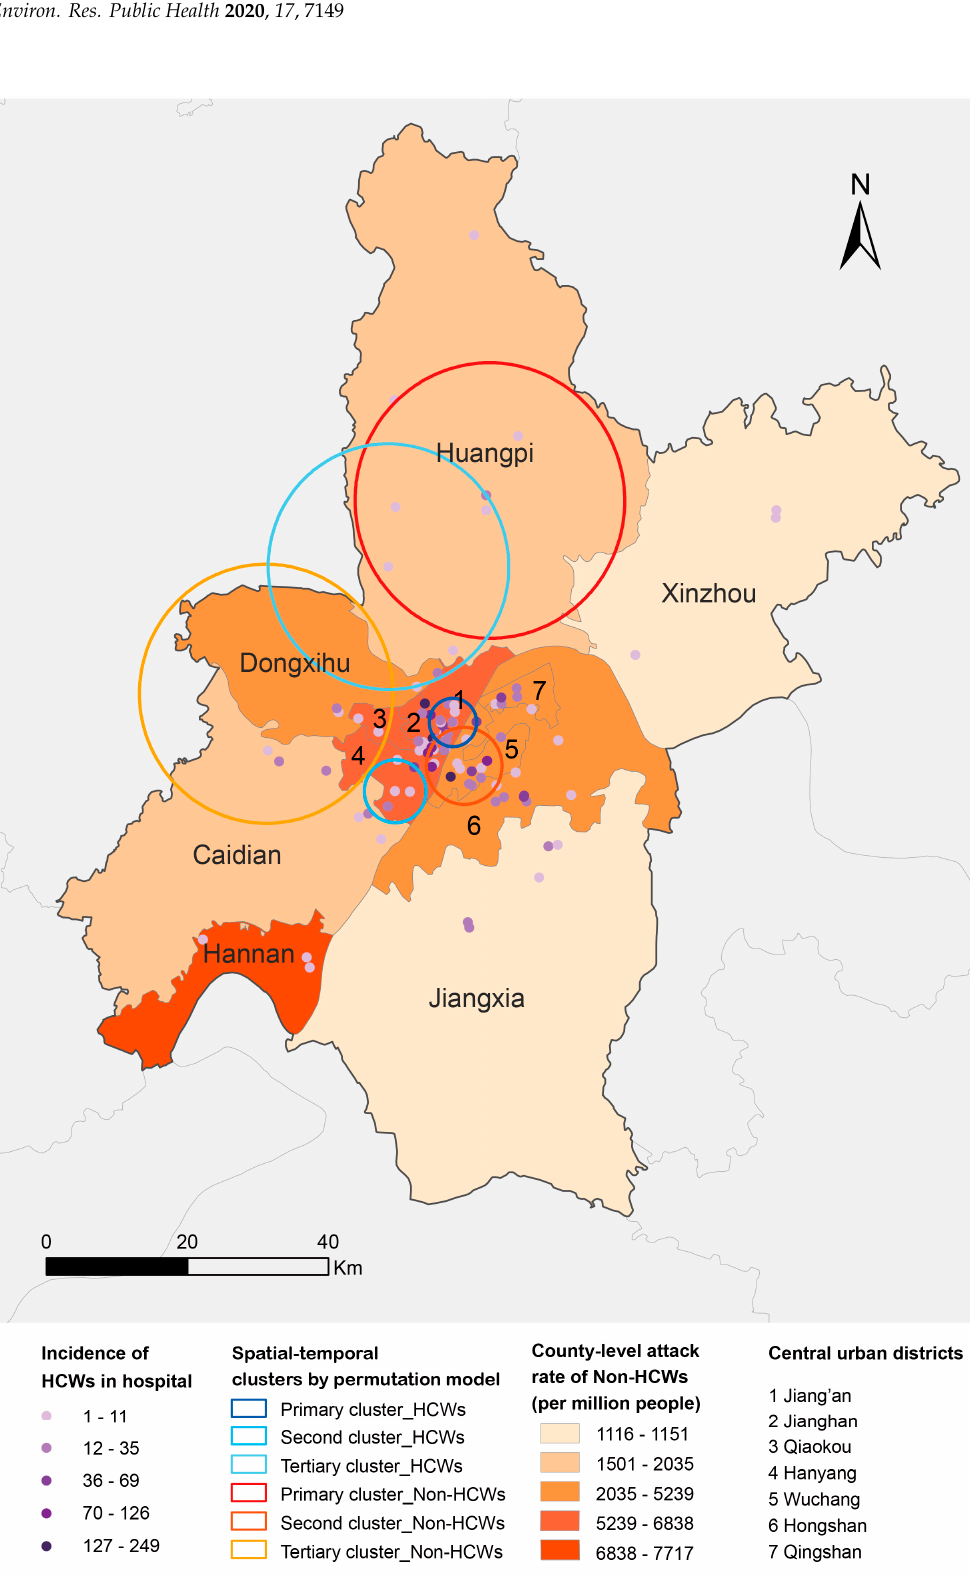
Figure 2. Distributions with spatial-temporal clusters of healthcare workers (HCWs) and non-HCW cases of COVID-19 in Wuhan. For HCWs, the number of cases was counted in each affected hospital, for non-HCWs, the attack rate was calculated in each county. Spatial-temporal clusters were identified by permutation model in HCW and non-HCW cases.